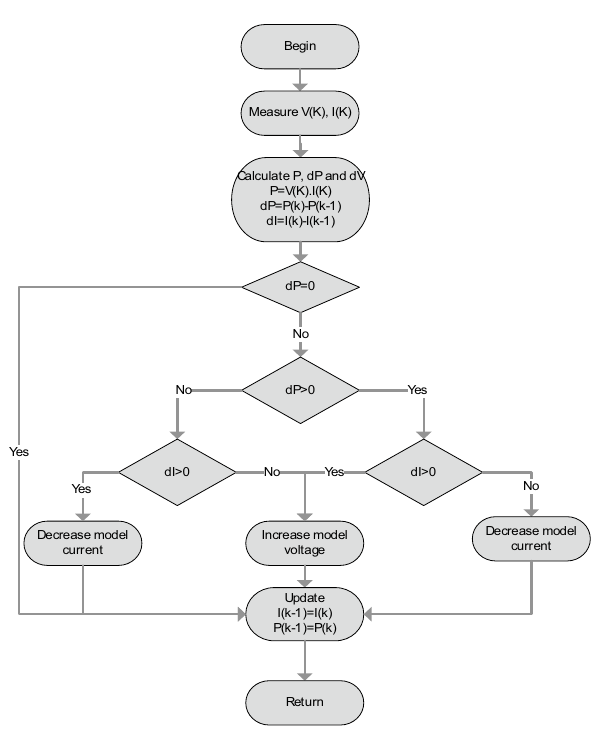
Fig. 5 Flow chart of perturbation and observation (P&O)